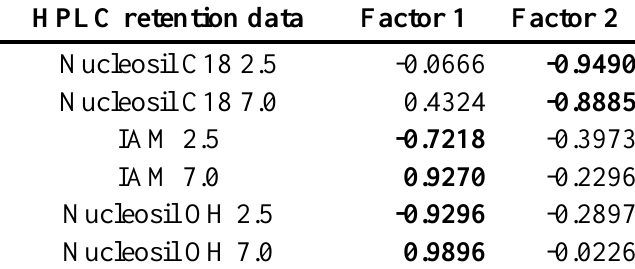
Table 5. Principal component analysis loadings by HPLC retention data.